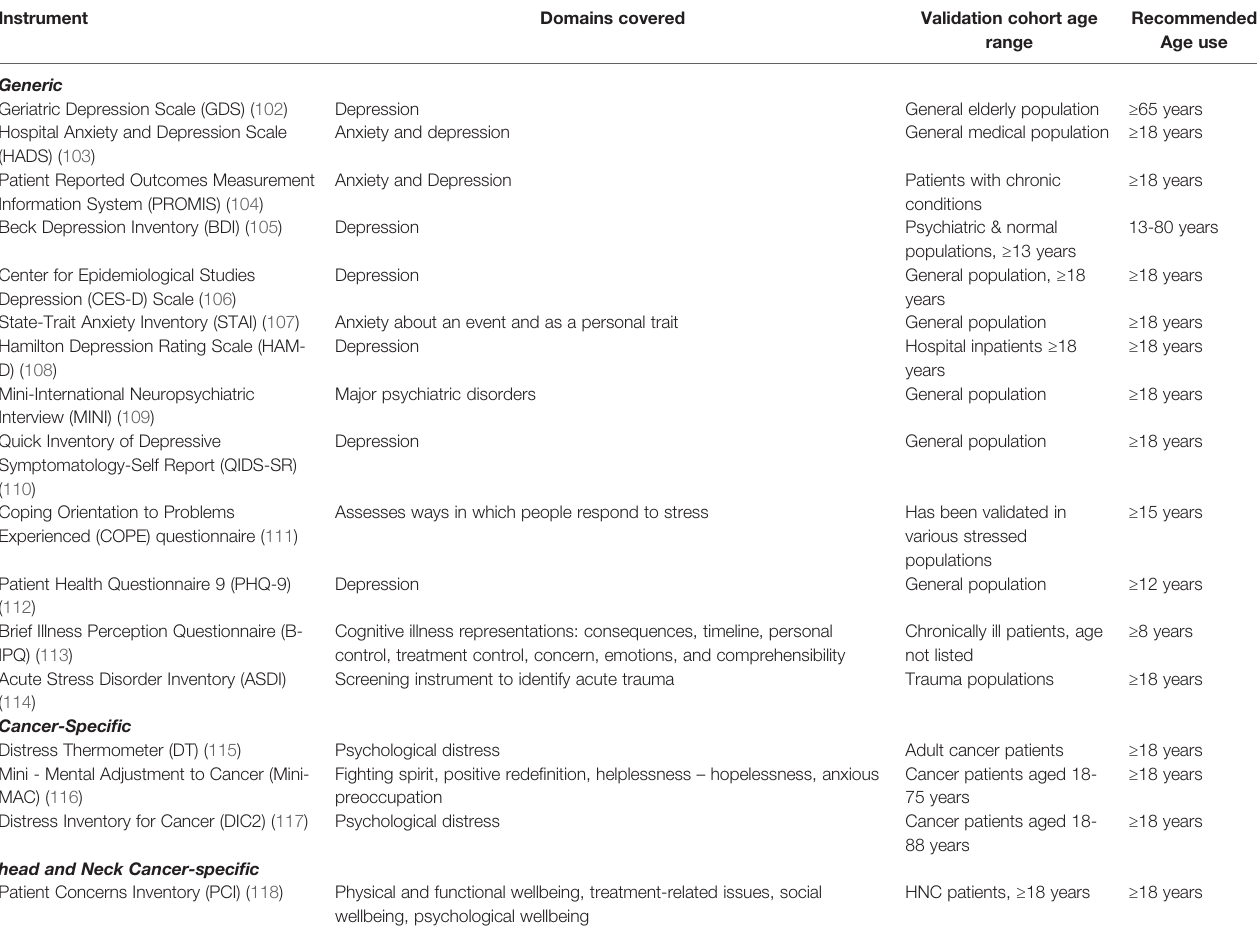
TABLE 7 | Common Instruments used to capture distress in HNC